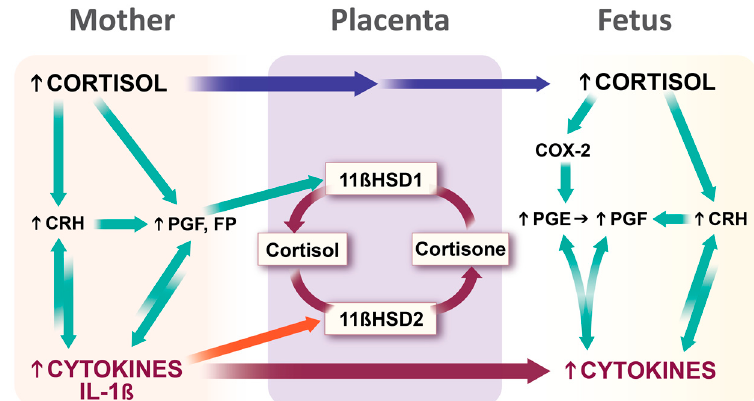
Figure 4. Role of placenta in transmission of generational stressors from mother to fetus. Increased fetal cortisol can be derived from elevated maternal cortisol concentrations via a high concentration gradient plus maternal cortisol-induced stimulation of corticotrophin releasing hormone (CRH) and prostaglandins (PGs) in placenta and fetal membranes. PGF2 α in turn stimulates 11 β -hydroxysteroid dehydrogenase type 1 (11 β HSD1) that converts the less biologically active cortisone to cortisol. Further, CRH and PGF2 α can stimulate cytokine production, and in turn cytokines stimulate CRH and PGF production. Several cytokines, including IL-1 β , inhibit the enzyme, 11 β HSD2, which converts cortisol to cortisone, thereby decreasing the metabolism of cortisol. The net effect of increased activity of 11 β HSD1 and decreased 11 β HSD2 activity is an increased cortisol gradient and reduced metabolism leading to higher concentrations of fetal cortisol. Maternal cytokines can stimulate the production of fetal cytokines directly through cytokine stimulation and indirectly through CRH and PGF2 α . Increased cortisol and cytokines in the fetal compartment amplify the production of more fetal cytokines, PGs and CRH and permit more cortisol to cross the placenta thereby increasing fetal circulating cortisol concentrations. Legend: Green arrows stimulatory; red curved arrows inhibitory, straight maroon and blue arrows passage through placenta.